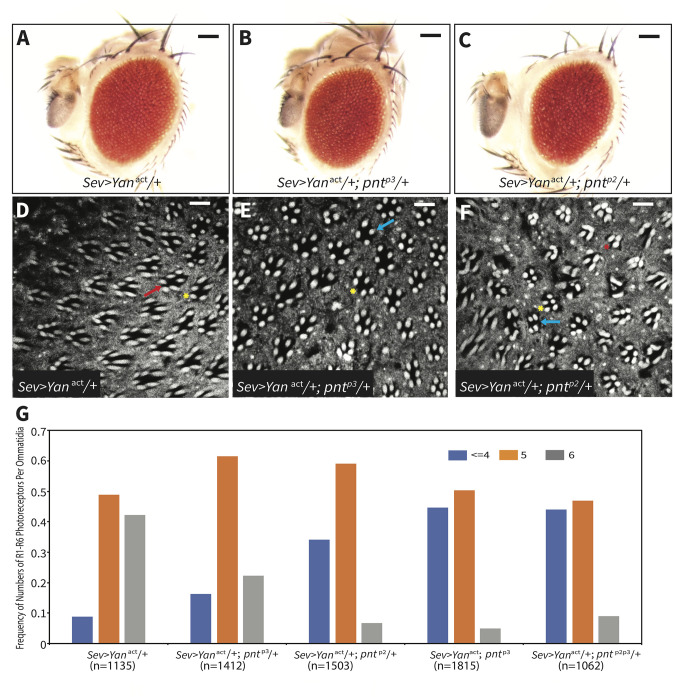
PntP2 and PntP3 stabilize R3/R4 fate transitions against compromised RTK signaling.(A-F) Heterozygosity for either pntp3 or pntp2 dominantly enhances the Sev-Yanact induced disruption in external eye morphology and photoreceptor loss. (A-C) Representative adult eyes of indicated genotype. Scale bar: 50 μm. (D-F) Phalloidin staining of representative adult eyes of indicated genotype. Red arrow points to the ommatidium lacking the R7 rhabdomere, yellow stars indicate ommatidia with five outer rhabdomeres, blue arrows point to ommatidia with four outer rhabdomeres and red star indicates the ommatidium with three outer rhabdomeres. Scale bar: 5 μm. (G) Quantification of photoreceptor loss in phalloidin-stained adult eyes expressed as the frequency of ommatidia with 6, 5, or < = 4 remaining outer rhabdomeres. n represents the number of ommatidia scored for each genotype. In the Sev-Yanact controls, ommatidia with 5 or 6 outer rhabdomeres were present at a roughly 1:1 ratio and less than 10% of ommatidia had fewer than 4. Heterozygosity for either pntp3 or pntp2 shifted this distribution: for both, the majority of ommatidia (~60%) had 5 outer rhabdomeres. However reduction in pntp2 caused a larger increase in fraction of ommatidia with 4 or fewer outer rhabdomeres than did reduction in pntp3. When both copies of pntp3 were removed, ommatidia with < = 4 or 5 outer rhabdomeres were present at a roughly 1:1 ratio and less than 10% of ommatidia had 6 rhabdomeres. A similar enhancement pattern was scored in animals heterozygous for the double mutant pntp2p3.